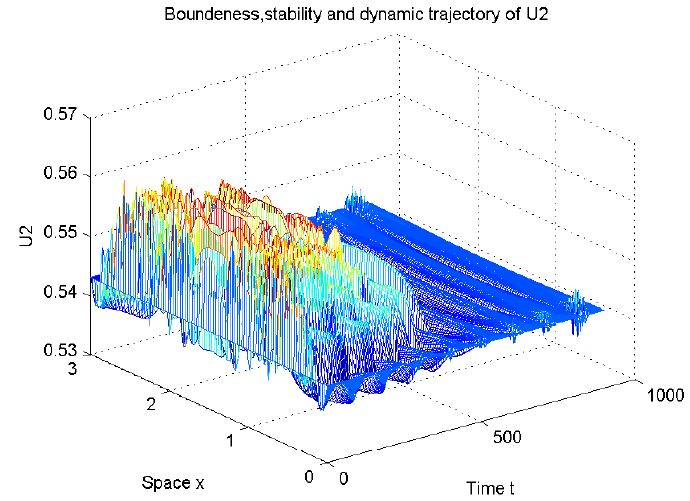
Figure 15. Computer simulation of dynamics of the investment demand U 2 .